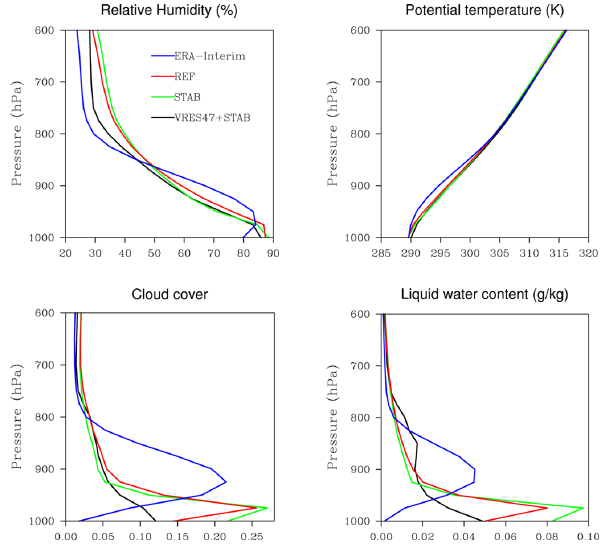
Figure 8. Vertical profiles of relative humidity, potential temper- ature, cloud cover and liquid water content in the stratocumulus regime. The red line is for the ECHAM6-HAM2 reference simu- lation, the green line for the STAB simulation, the black line for the VRES47 + STAB simulation and the blue line for ERA-Interim